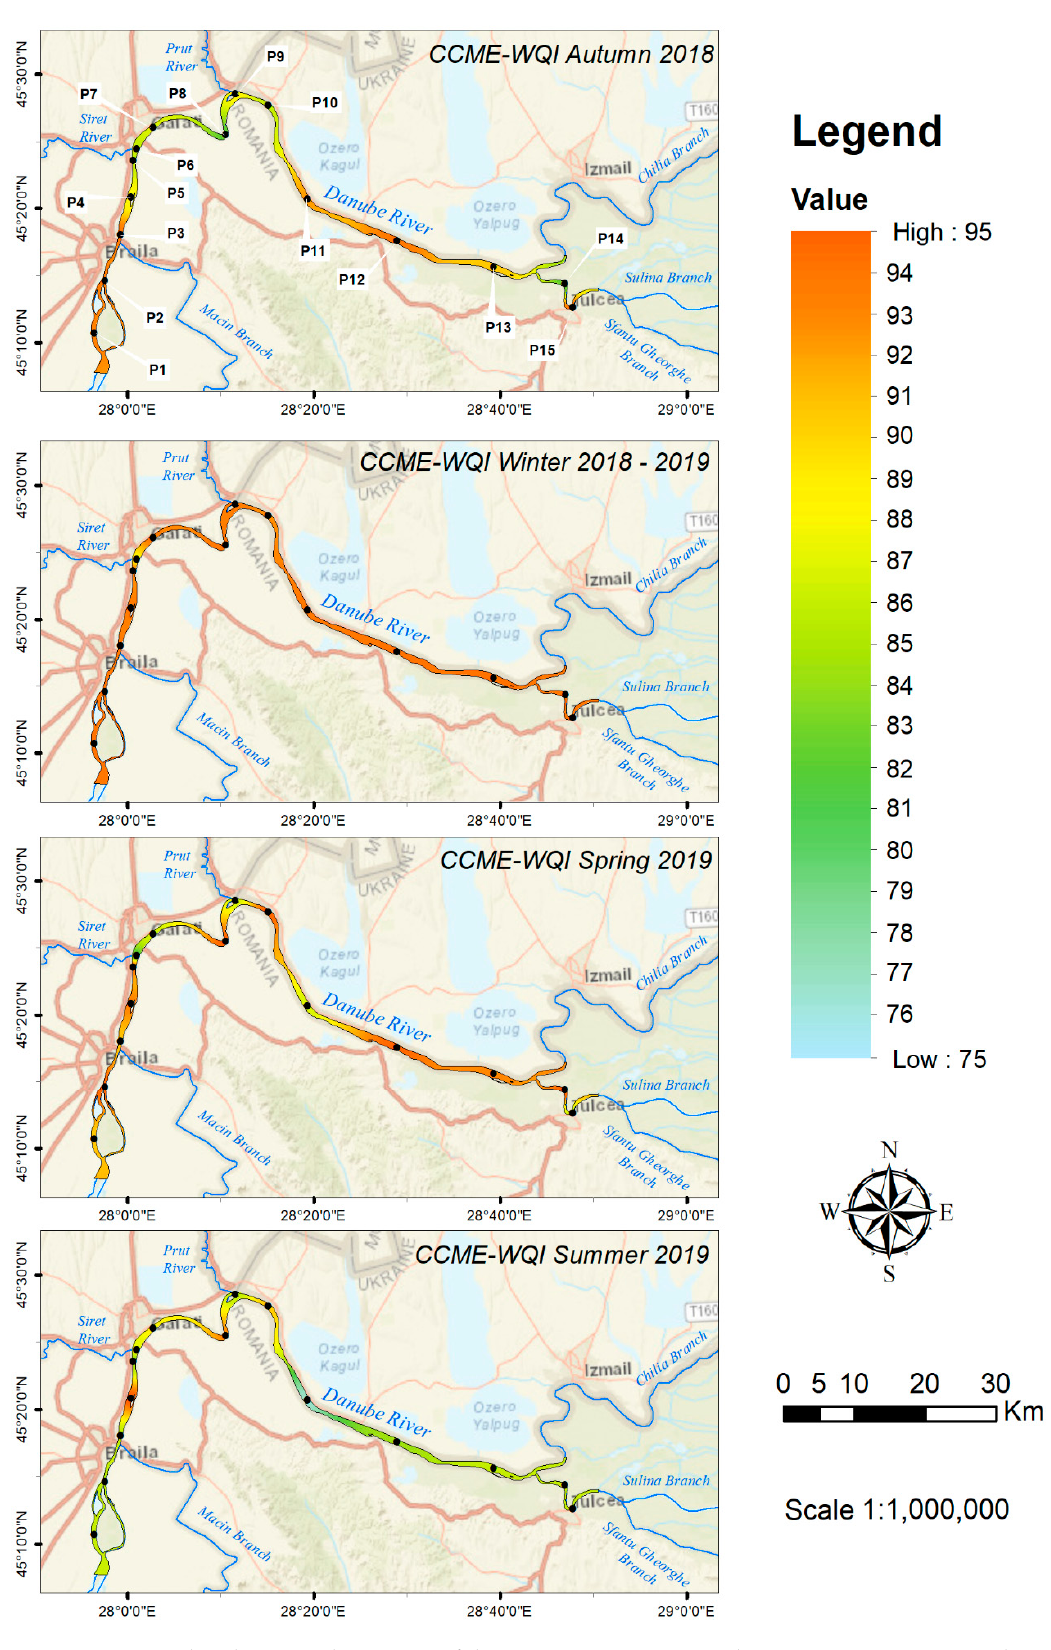
Figure 4. Spatial and temporal variation of the CCME-WQI scores in the Romanian Lower Danube sector recorded during the period autumn 2018–summer 2019.